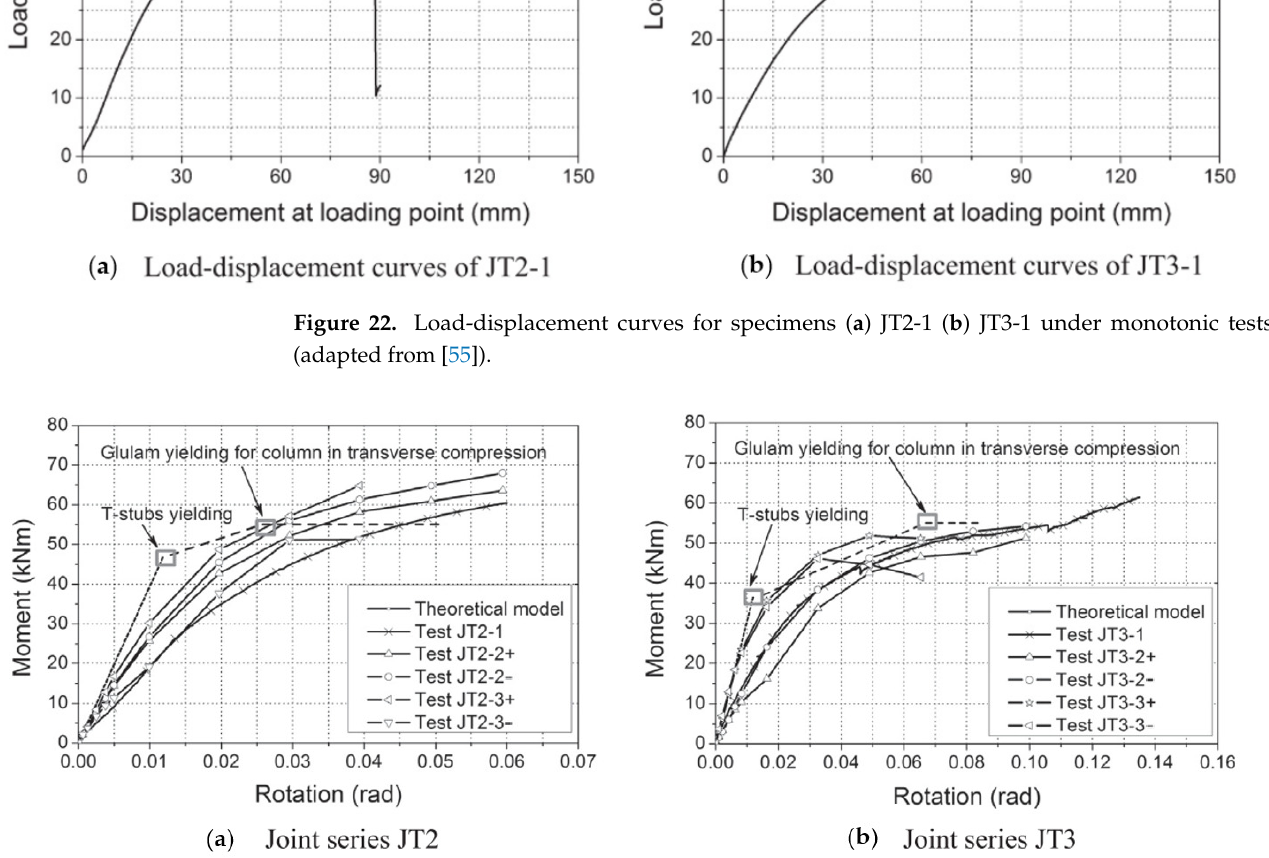
Figure 23. Moment–rotation curves for monotonic tests, adapted from [55].